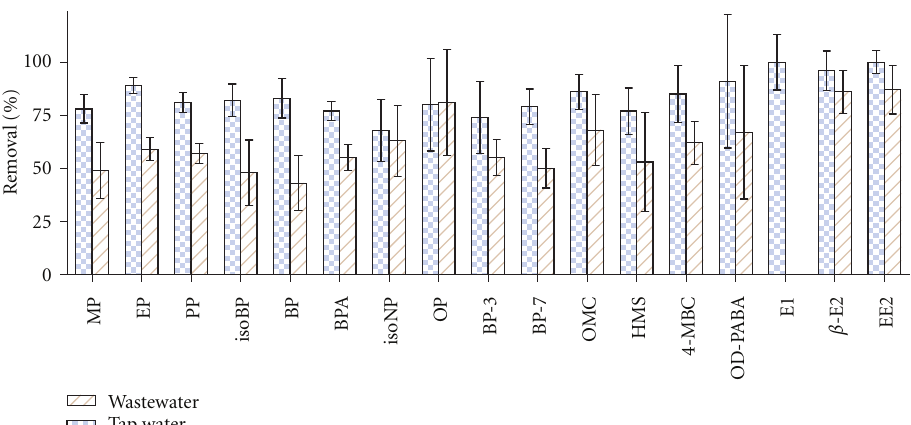
Figure 2: The removal of estrogenic compounds from tap water and wastewater e ffl uent by UV/H 2 O 2 . The electrical energy dose was 1.8kWh/m 3 , and the initial concentration of hydrogen peroxide was 60mg/L. The error bars present the 95% confidence